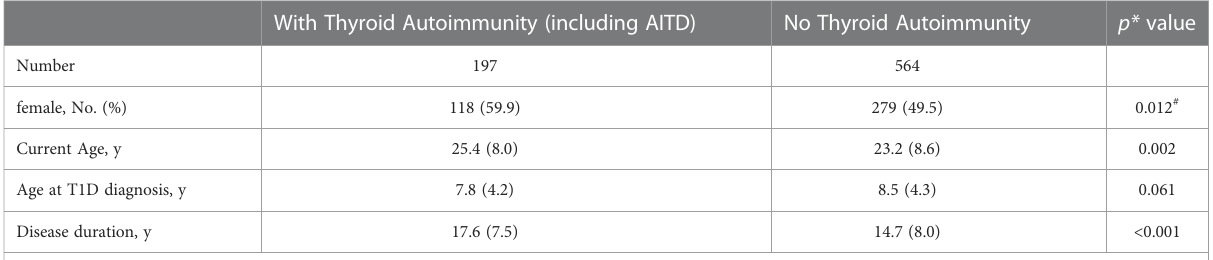
TABLE 1 Comparison between patients with and those without thyroid autoimmunity. With Thyroid Autoimmunity (including AITD) No Thyroid